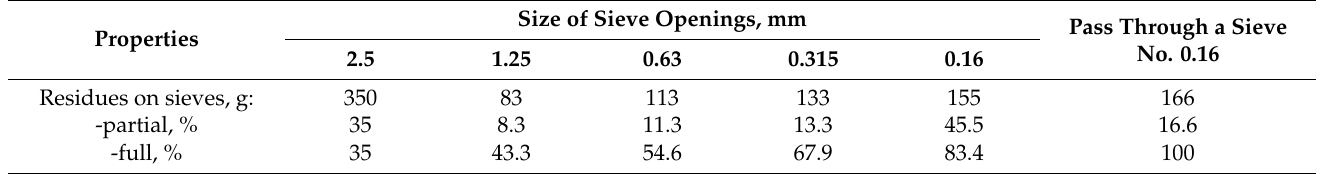
Table 2. Particle sizes of the crushed concrete